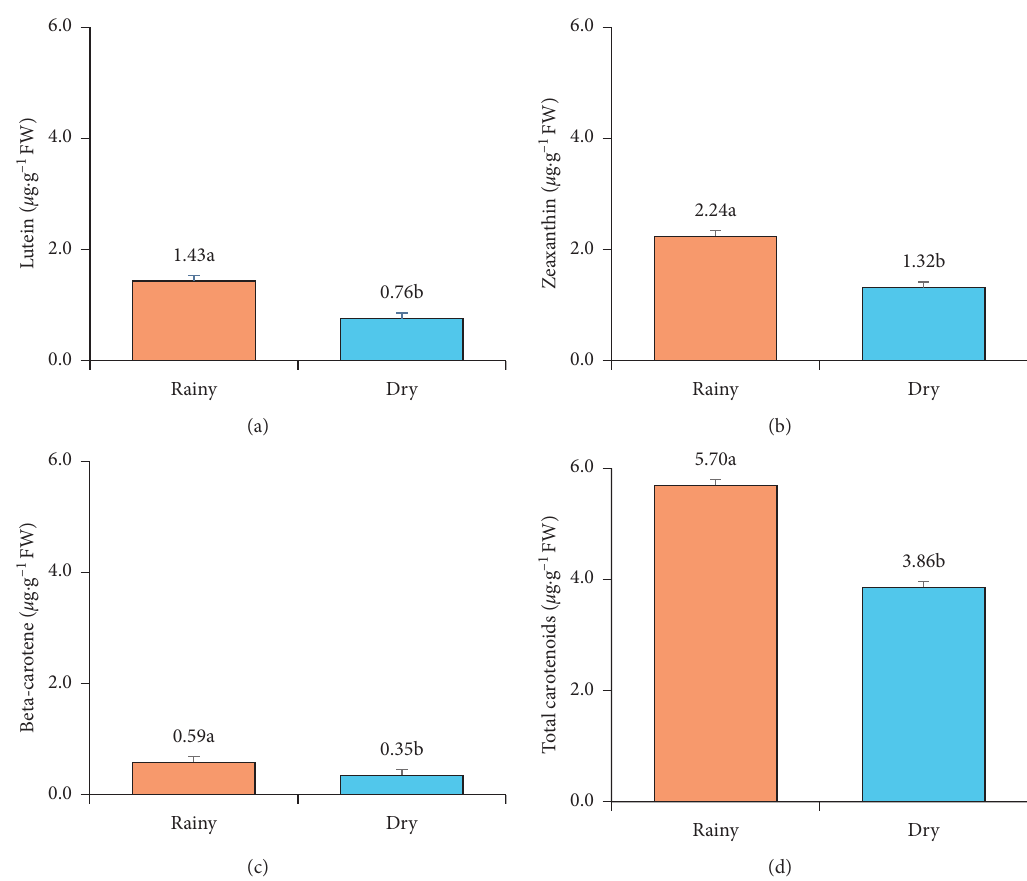
Figure 1: Seasonal effect on the grand means of 48 small-ear waxy corn genotypes for (a) lutein content, (b) zeaxanthin content, (c) beta- carotene content, and (d) total carotenoids content evaluated in the dry season 2018/2019 and rainy season 2019 in Khon Kaen. Means followed by different letters across bars are significantly different based on LSD at p � 0 .